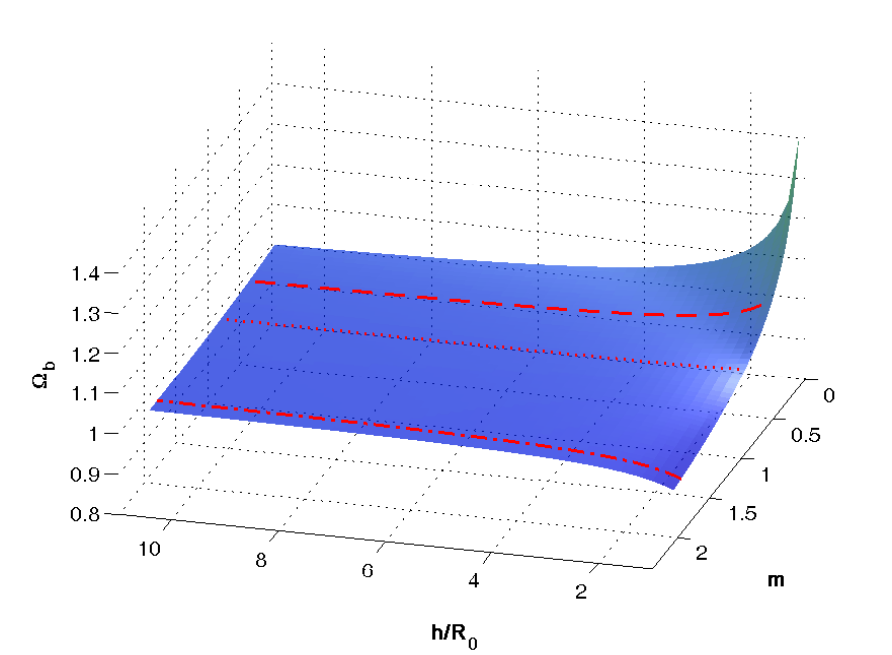
Figure 6. Normalized natural frequency as function of distance to boundary ( h / R 0 ) and the ratio of densities m . Dash-dotted curve corresponds to bubble above sediment layer ( m = 1.95). Dotted line describes dependence of natural frequency for bubble in blood near artery wall ( m = 0.86). Dashed line corresponds to bubble in sediments ( m =